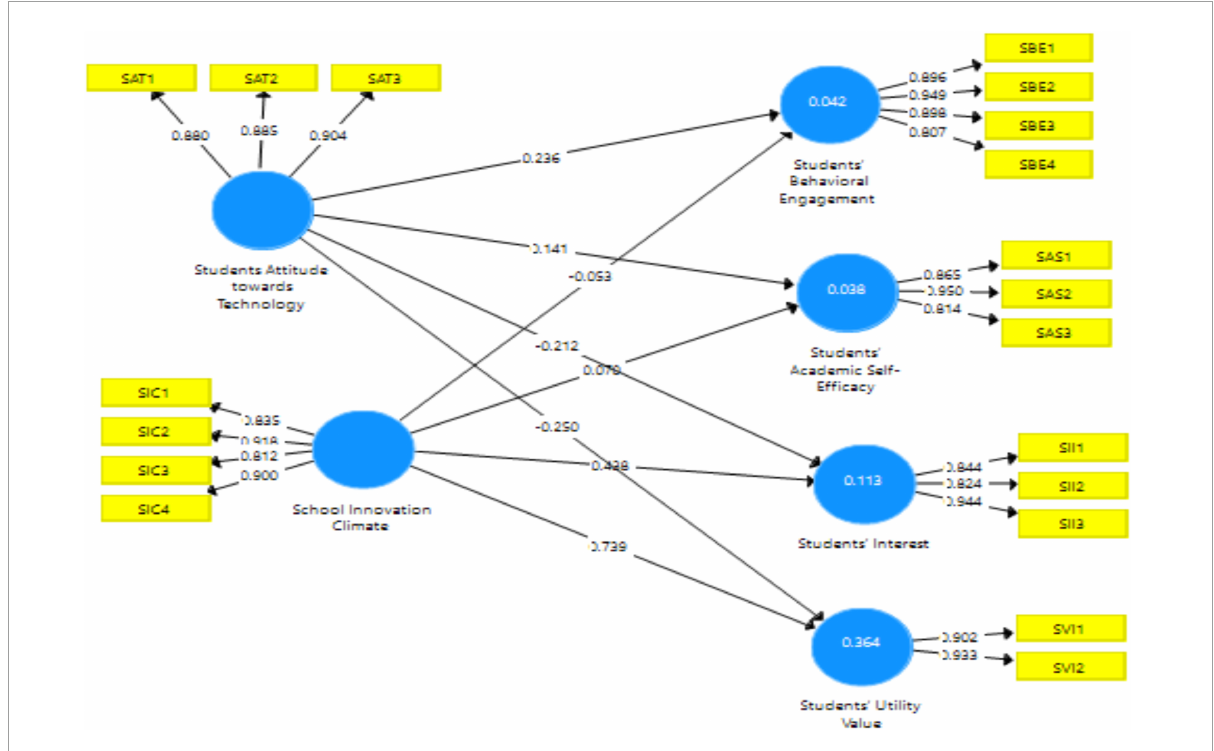
FIGURE2 Measurement model.